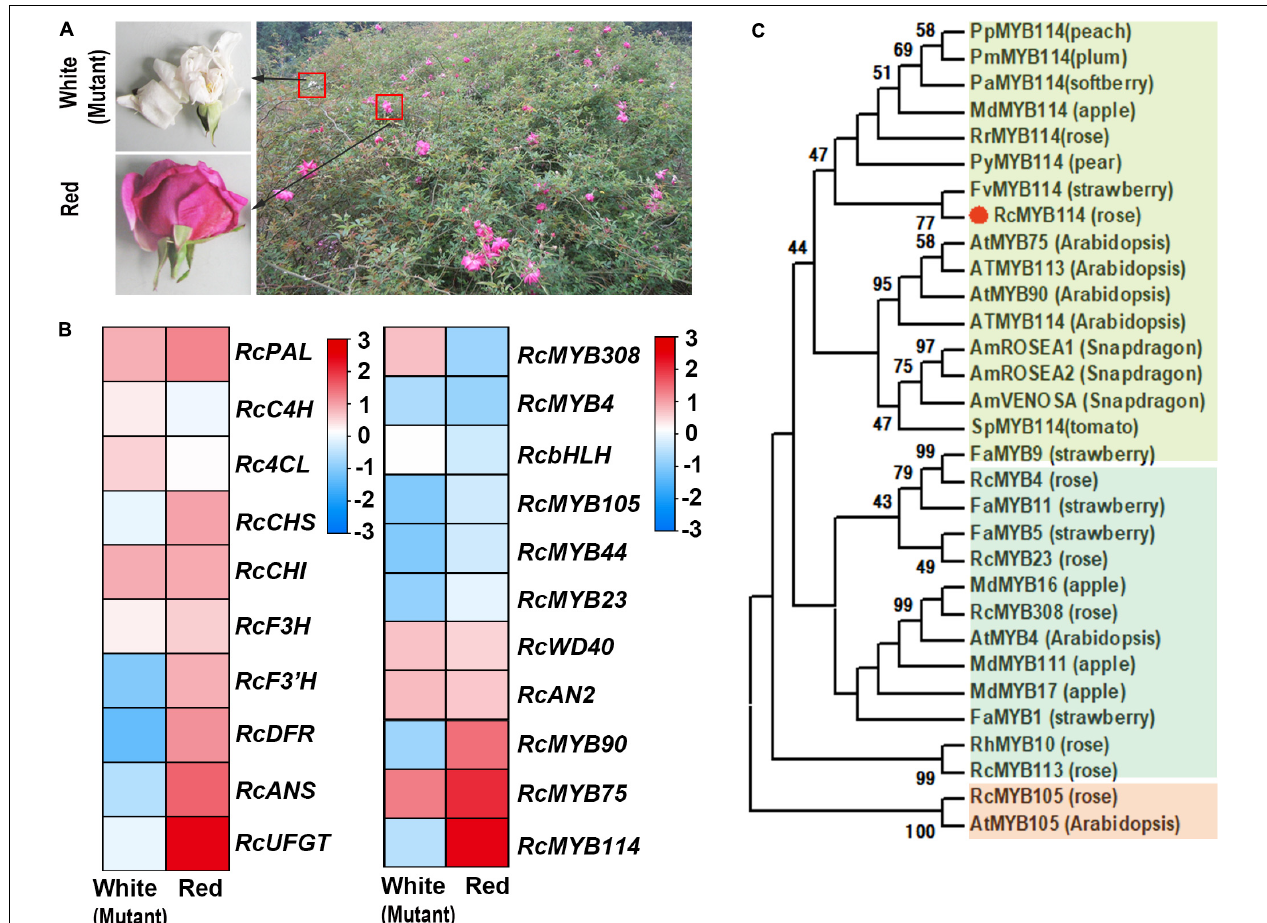
FIGURE 1 | Identification of the gene ( RcMYB114 ) regulating anthocyanin biosynthesis in our mutant rose. (A) A red rose ( R. chinensis ‘Semperflorens’ cv. ‘Slater’s Crimson China’) specimen was found to contain both red and white (mutant) flowers. (B) RNA-seq heat map of genes related to anthocyanin biosynthesis. (C) Evolutionary analysis of MYB